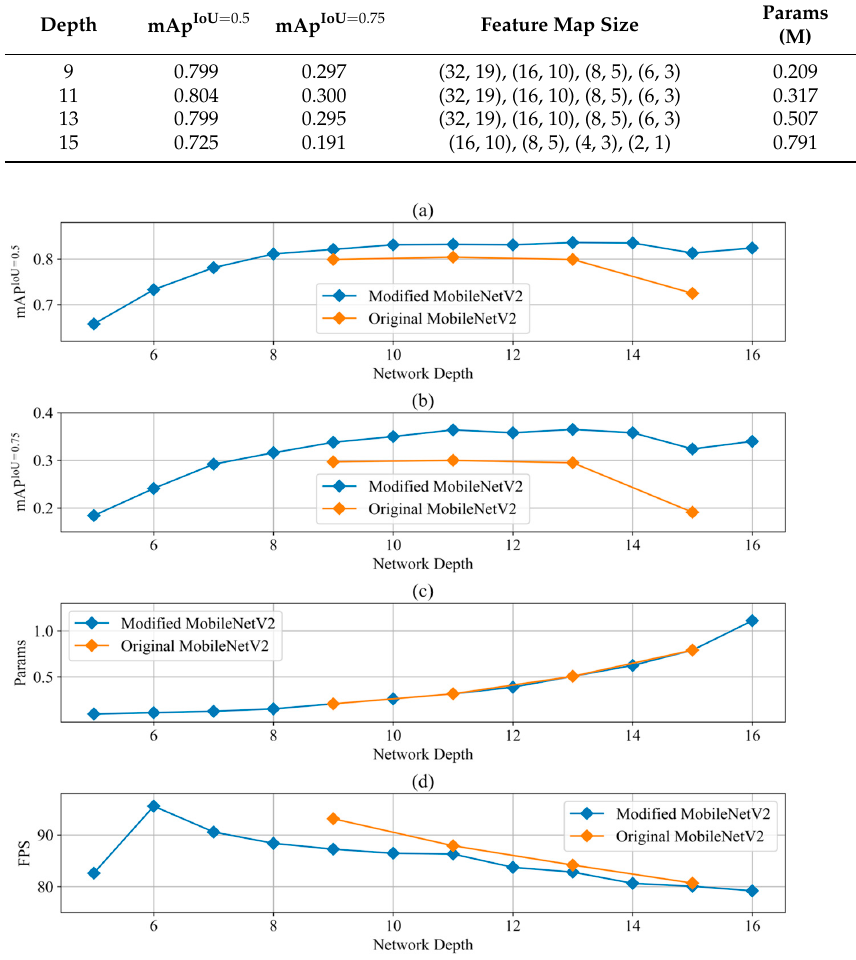
Figure 8. Relationship between base network depth and Autofocus SSD prediction performance: ( a ) IoU=0.5 mAP , ( b ) IoU=0.75 mAP , ( c ) Params, ( d ) FPS.